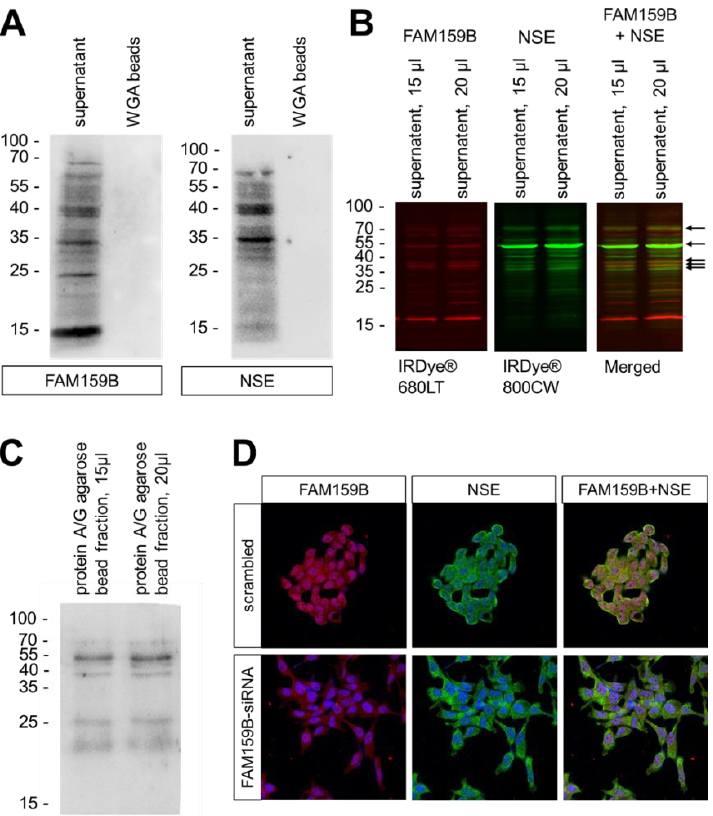
Figure 6. Association between FAM159B and neuron specific enolase (NSE) in BON-1 cells. ( A ) Western blot analysis of the cytosolic fraction (supernatant) and membrane preparations (WGA beads) of BON-1 cells endogenously expressing FAM159B and NSE. The ordinate shows migration of protein molecular-weight markers (kDa). Representative results from one of three independent ex- periments are shown. ( B ) Double-labelling Western blot analysis of the cytosolic fraction of FAM159B and NSE in BON-1 cells endogenously expressing FAM159B and NSE. FAM159B was visualised using IRDye ® 680 LT goat anti-rabbit IgG secondary antibody (red). NSE was visualised using IRDye ® 800 CW goat anti-mouse IgG secondary antibody (green). Overlapping bands (Merged) appear in orange/yellow colour (arrows). The ordinate shows migration of protein molecular-weight markers (kDa). Representative results from one of three independent experiments are shown. ( C ) Western blot analysis of the cytosolic fraction of BON-1 cells after co-immunoprecipitation of FAM159B and